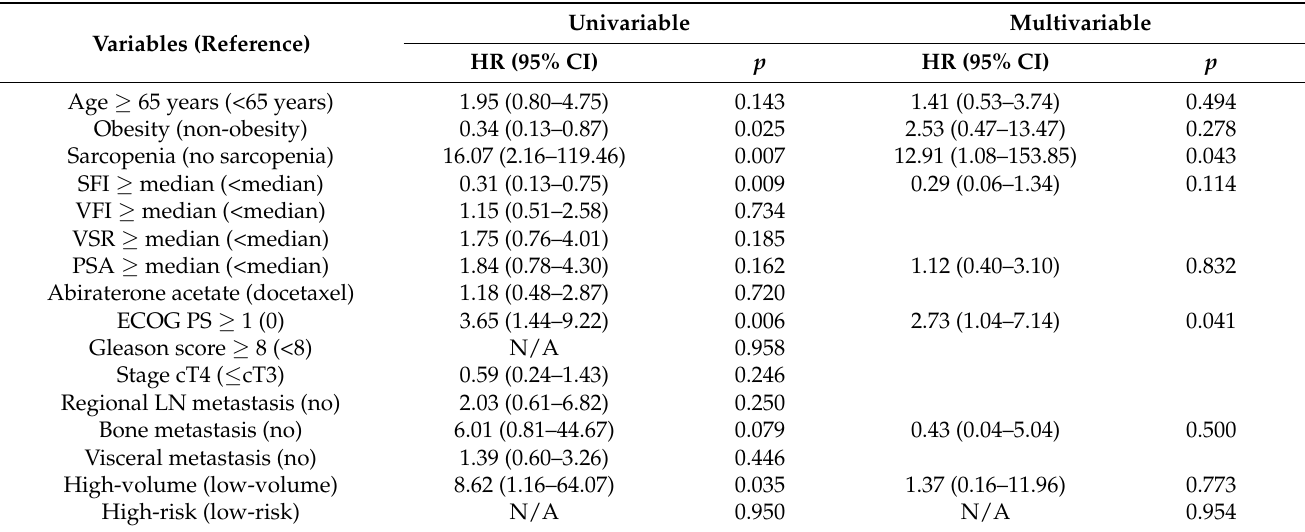
Table 4. Results of Cox regression analysis for time to PSA